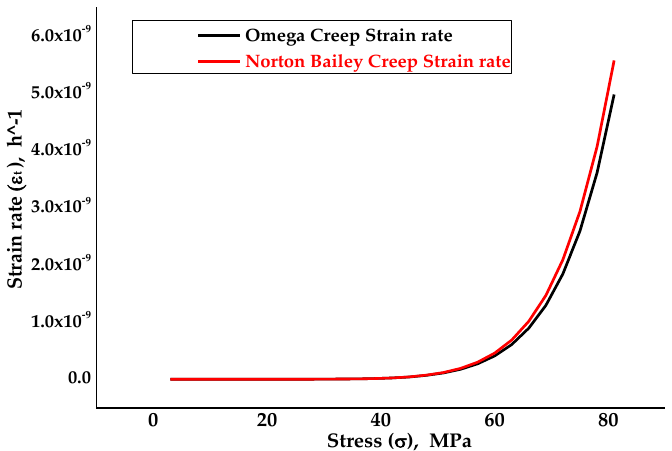
Figure 2. The resultant strain rate vs stress curve obtained following the curve fitting of MPC Omega to the Norton–Bailey model based on strain hardening [39].